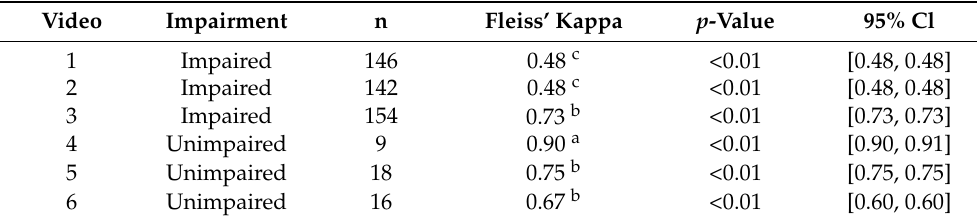
Table 4. Interrater reliability of the checklist based on responses of officers who underwent education in VERIFY. Details on rated impairments are listed in Table 3.